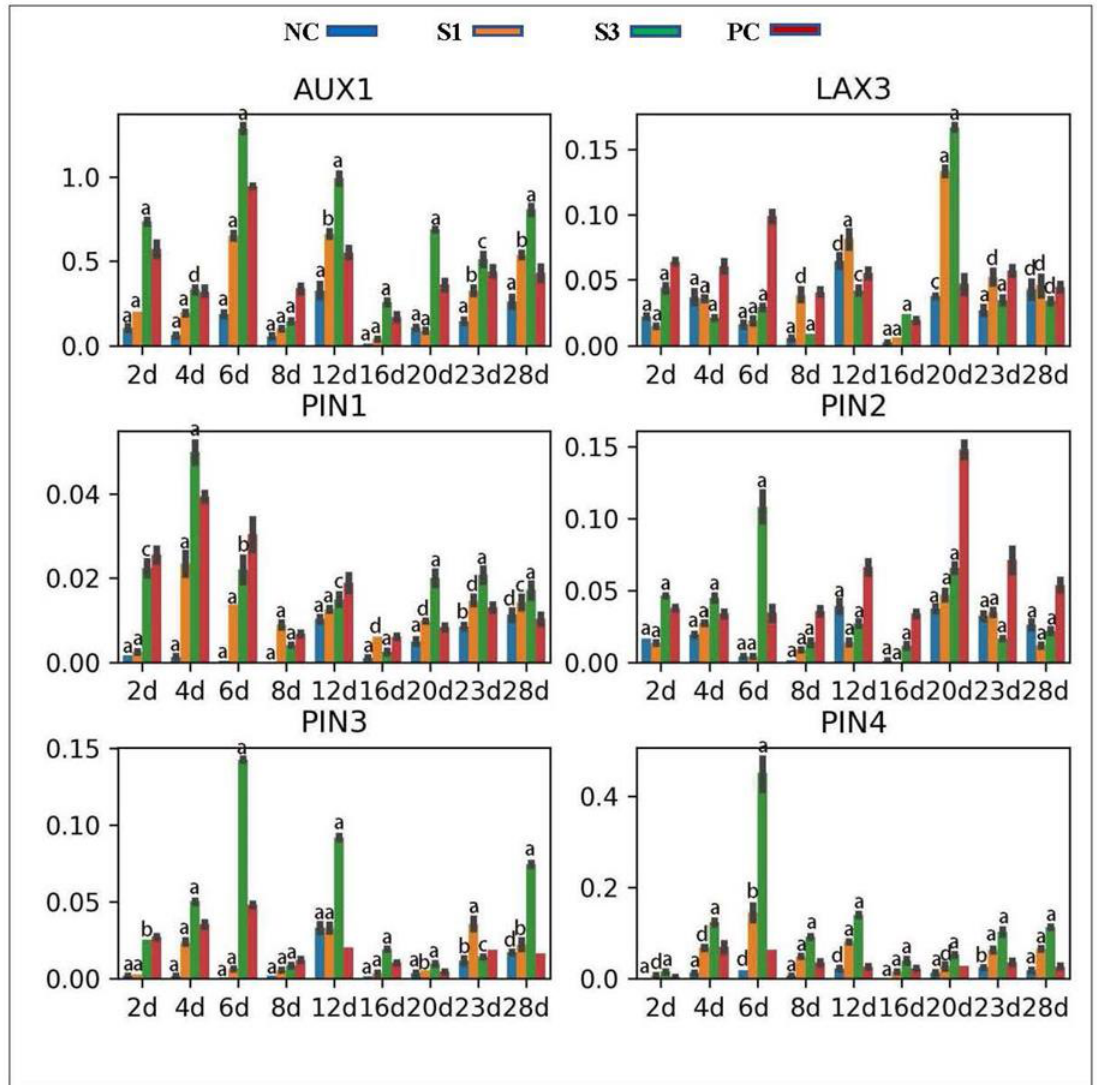
Figure 3. Expression profiles of AUX1/LAX and PIN family genes in differently treated samples. Three biological replications were included. The reference gene was ubiquitin 10 ( UBQ10 ). a, b, c and d represented the difference in gene expression levels in the samples treated by exogenous IAA compared to those in PC. a, p -value < 0.001; b, p -value < 0.01; c, p -value < 0.05; d, p -value > 0.05. Similar parameter settings were performed in the following figures.